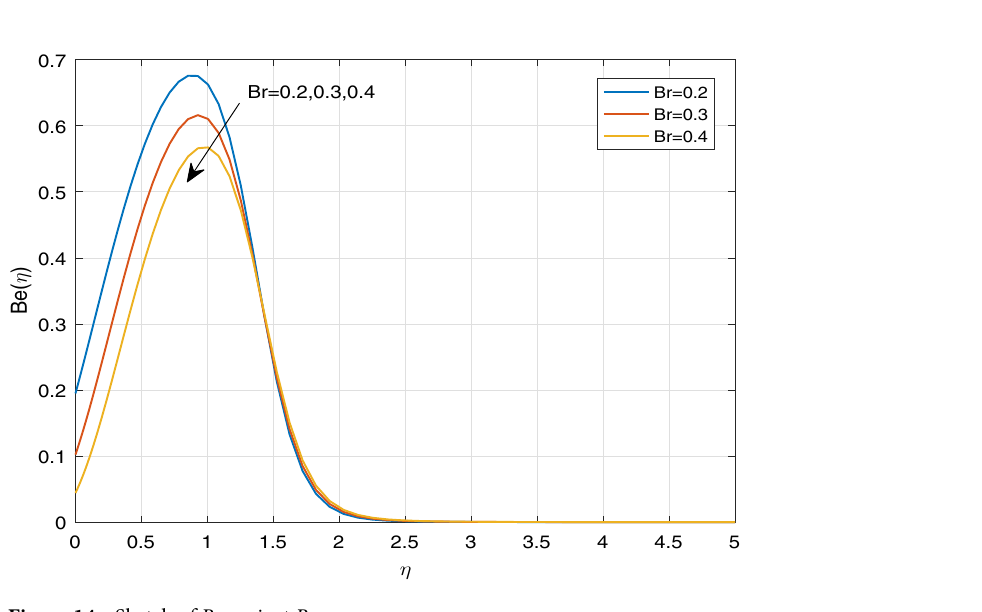
Figure 14. Sketch of Be against Br